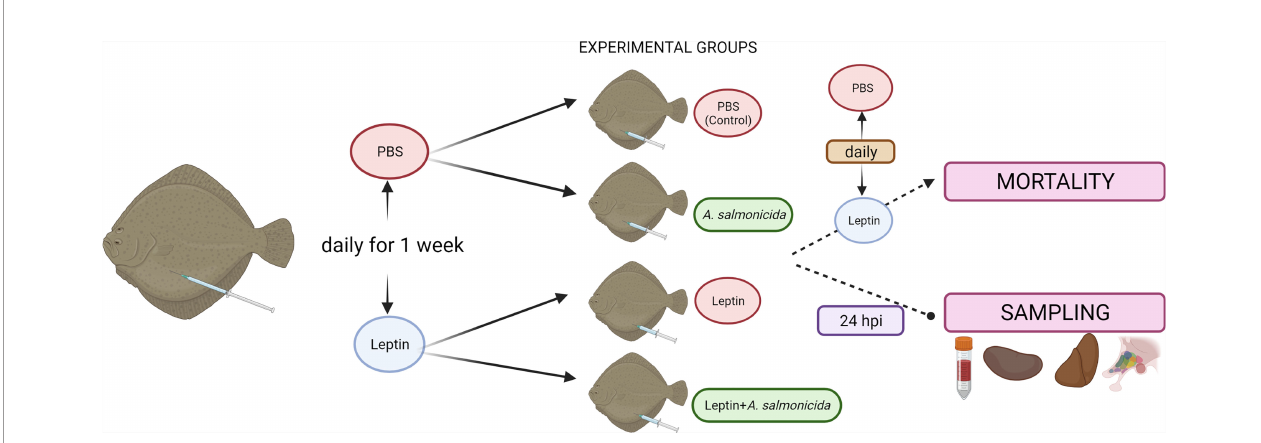
FIGURE 1 | Experimental design of the treatment with human recombinant leptin. For the mortality assay, two replicates of 10 fi sh were used per condition (control, leptin, A. salmonicida , Leptin + A. salmonicida ), and the assay was repeated three times. For tissue sampling, fourteen fi sh were used per experimental condition (8 fi sh for assessment of the metabolite levels and 6 fi sh for gene expression analysis). Figure created with